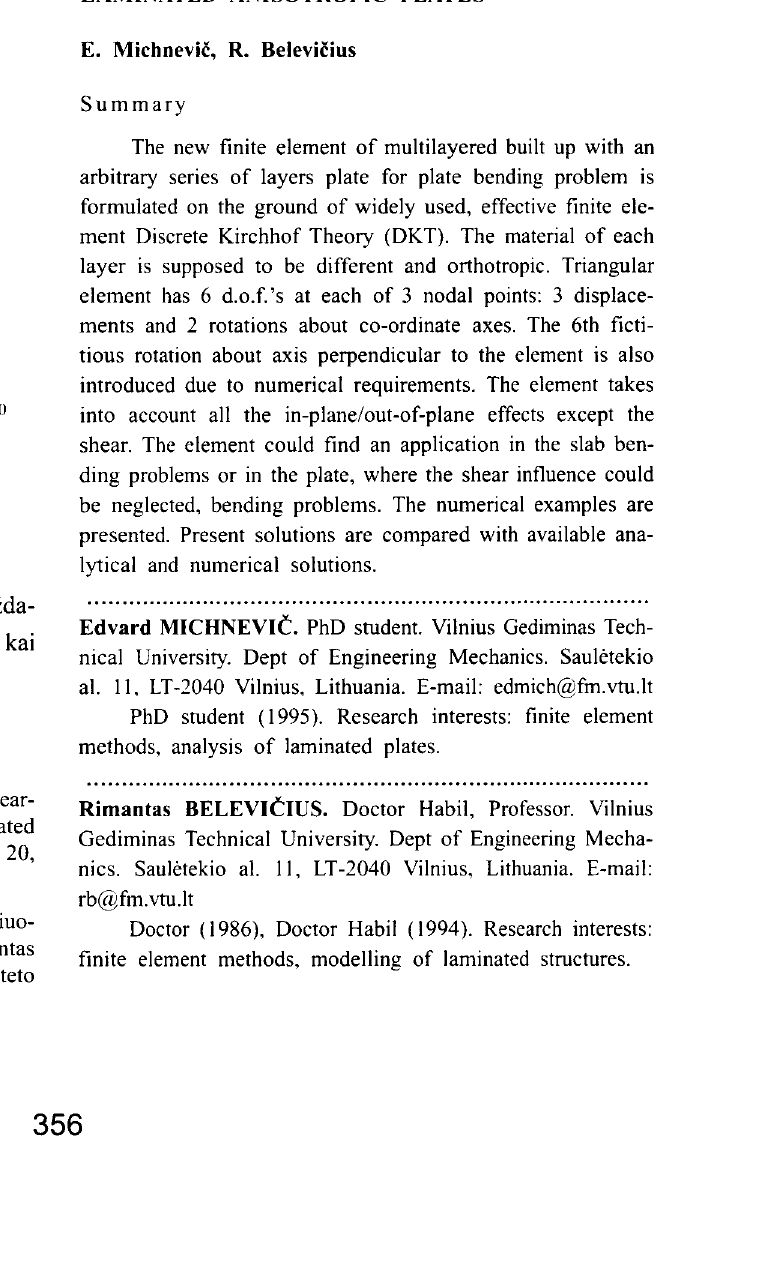
Fig 4. The first four eigenshapes